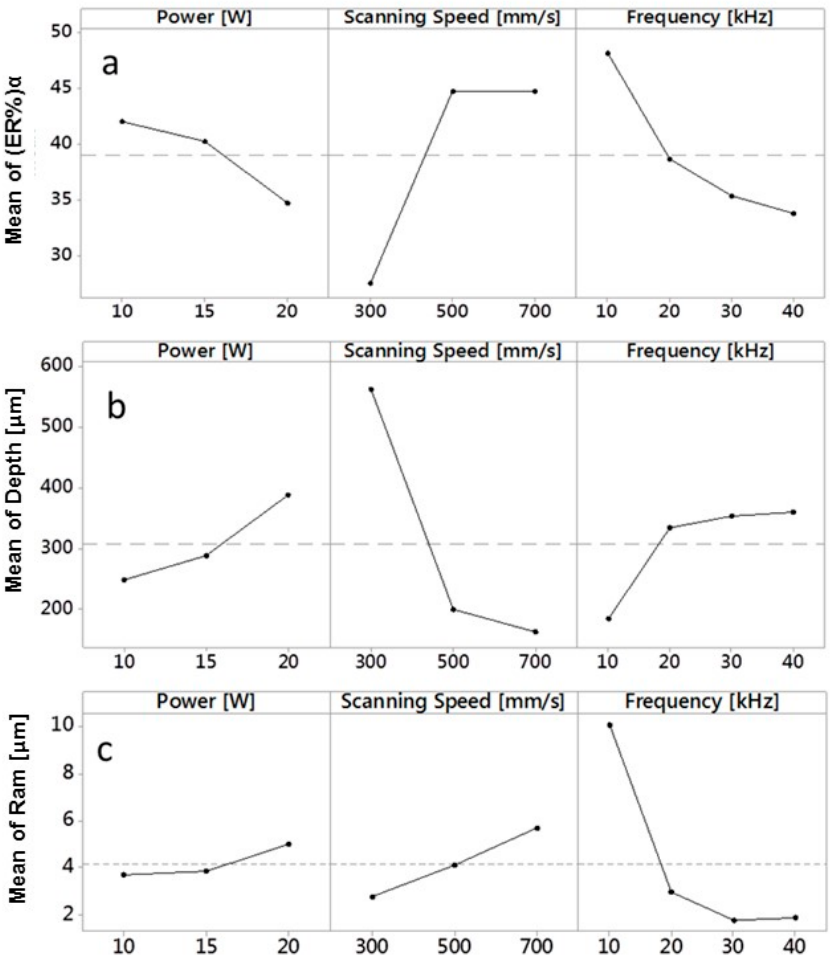
Figure 8. ( a ) Main effects plot for (ER%) α vs. Average Laser Power, Scanning Speed and Frequency; ( b ) Main effects plot for Depth vs. Average Laser Power, Scanning Speed and Frequency; ( c ) Main effects plot for Ram vs. Average Laser Power, Scanning Speed and Frequency.